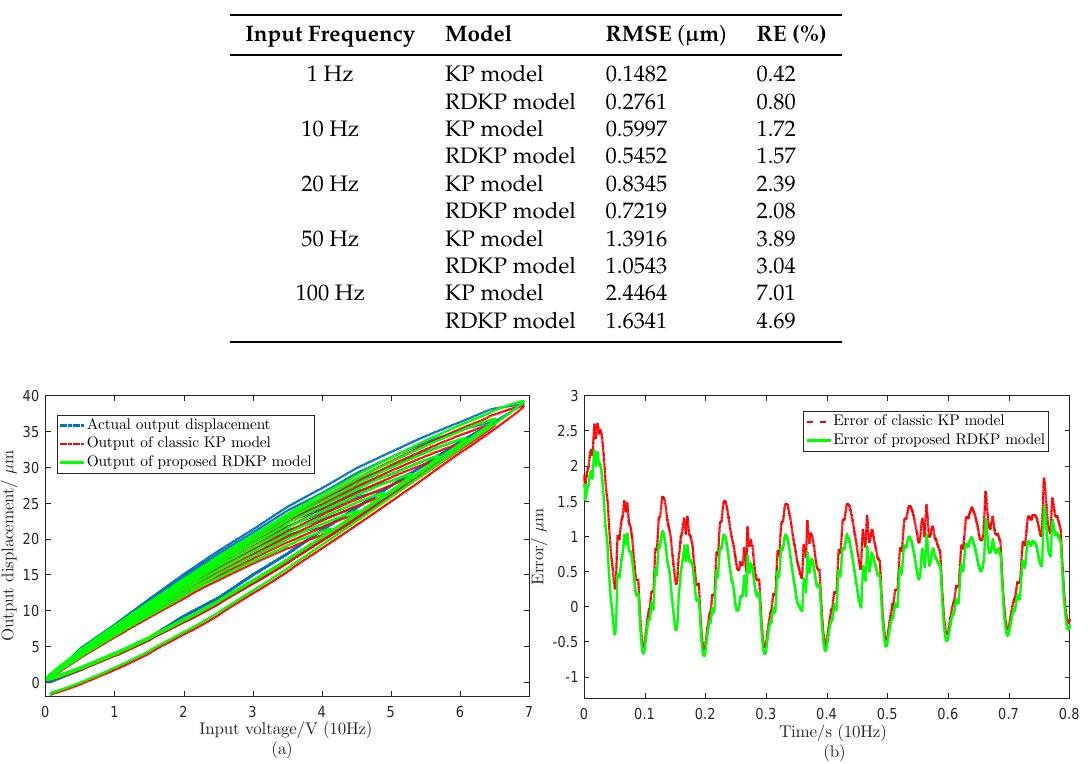
Table 1. Comparison of modeling errors between the classic KP model and the proposed RDKP model with diverse input frequency.